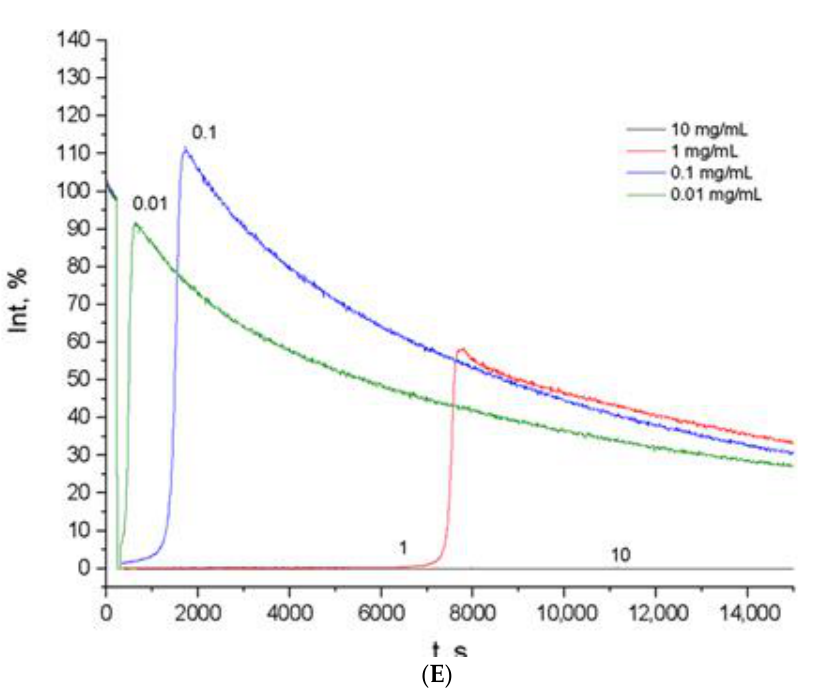
Figure 1. Chemiluminescence intensity vs. time of ethanol extracts from flowers of Centaurea cyanus L. ( A ), Centaurea scabiosa L. ( B ), Centaurea jacea L. ( C ), quercetin ( D ), and Trolox ( E ). The numbers beside the curves are the concentrations of Centaurea L. ethanol extract, dihydroquercetin, and Trolox (mg/mL). Time (s) is plotted on the abscissa axis and chemiluminescence intensity (a.u.) is plotted on the ordinate axis. Table 5. TRAP of ethanol extract from Centaurea L. flowers.